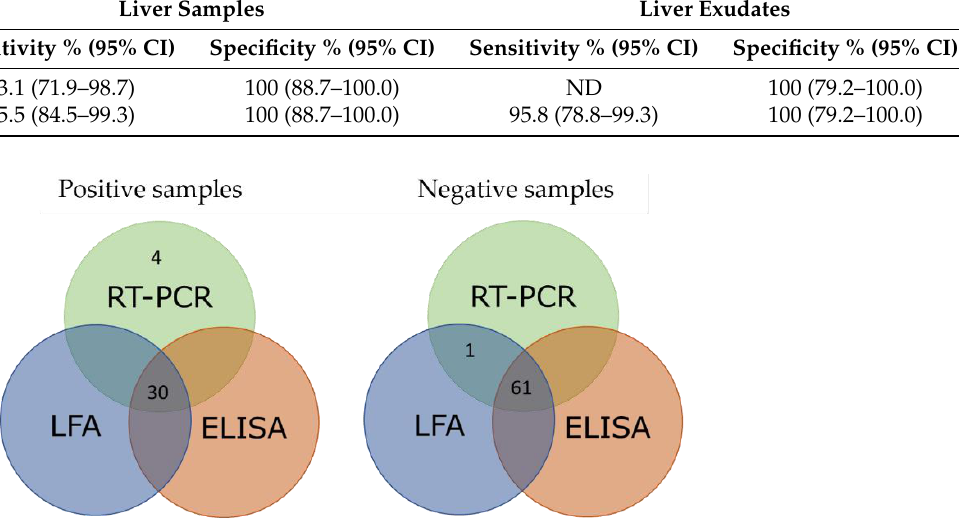
Figure 4. Venn diagram’s analysis of GI.1- or GI.2-positive and negative liver samples by RT-PCR, ELISA and